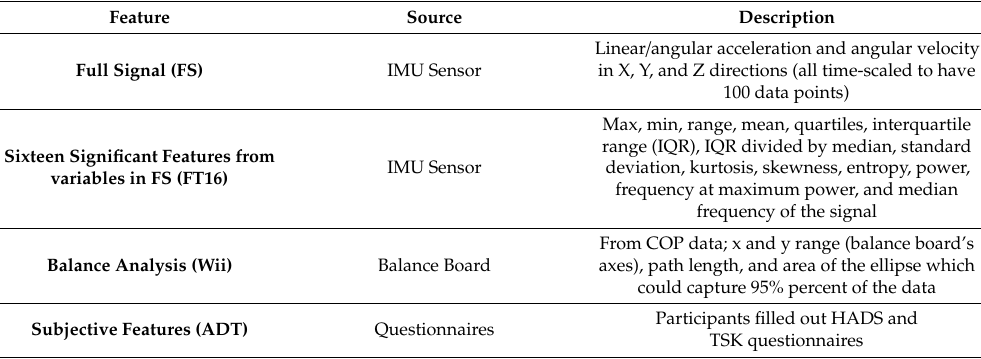
Table 2. The description of various features and their